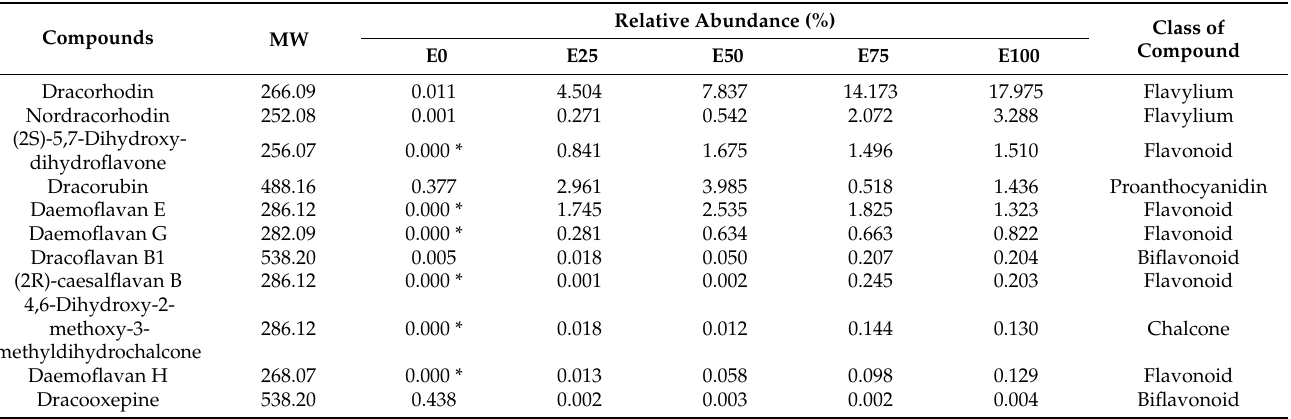
Table 6. The components of D. acehensis resin